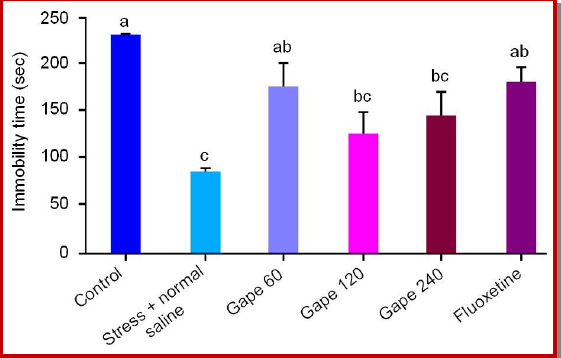
Figure 3: Effect of intraperitoneal injection of fluoxetine and different doses of grape seed oil on balance maintenance and resistance to movement